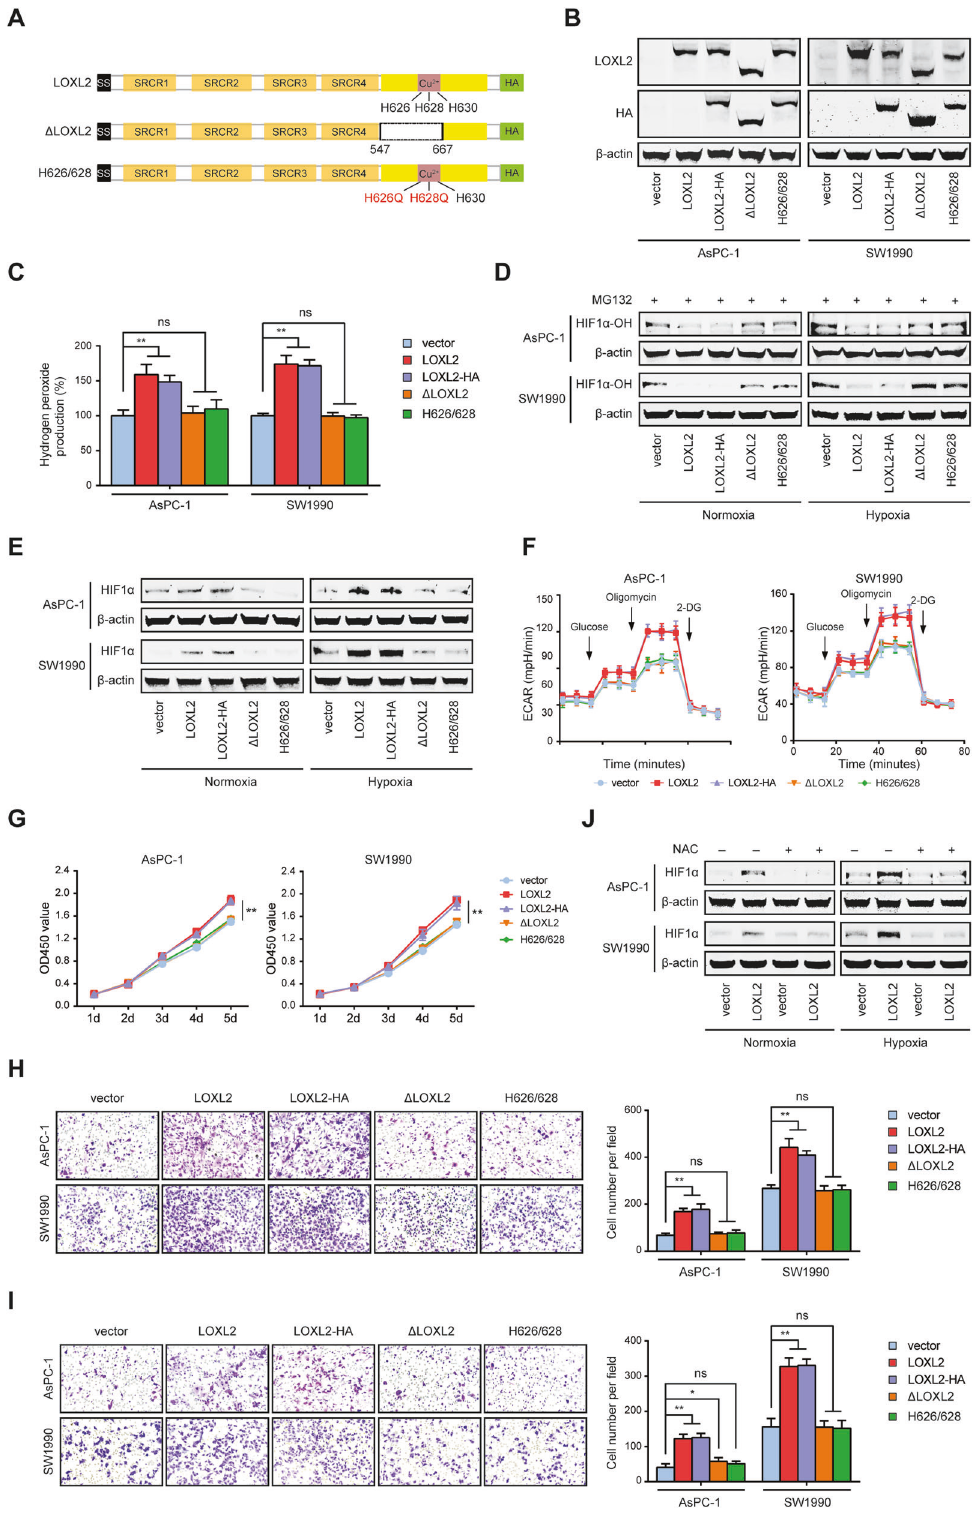
(1:1000, Proteintech, 11204-1-AP), ENO2 (1:1000, Protrintech, 66150-1-Ig), PKM2 (1:1000, Cell Signaling Technology, #3198), LDHA (1:5000, Protein- tech, 19987-1-AP), HA (1:1000, Millipore, 05-904), and β -actin (1:5000, MultiSciences, ab008). The next day, secondary antibodies conjugated